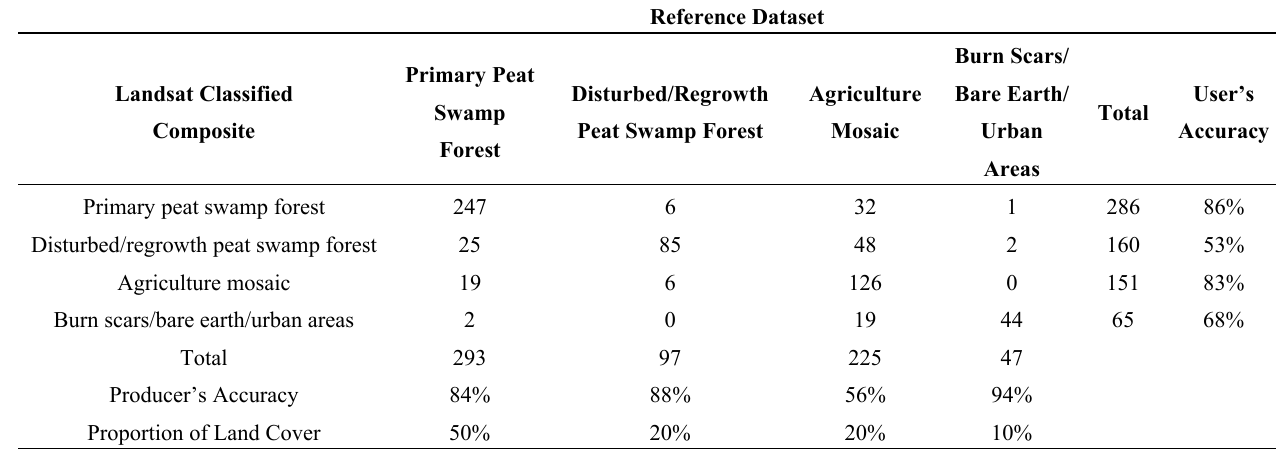
Table 2. Confusion matrix for 2000 peat swamp forest-cover composite in